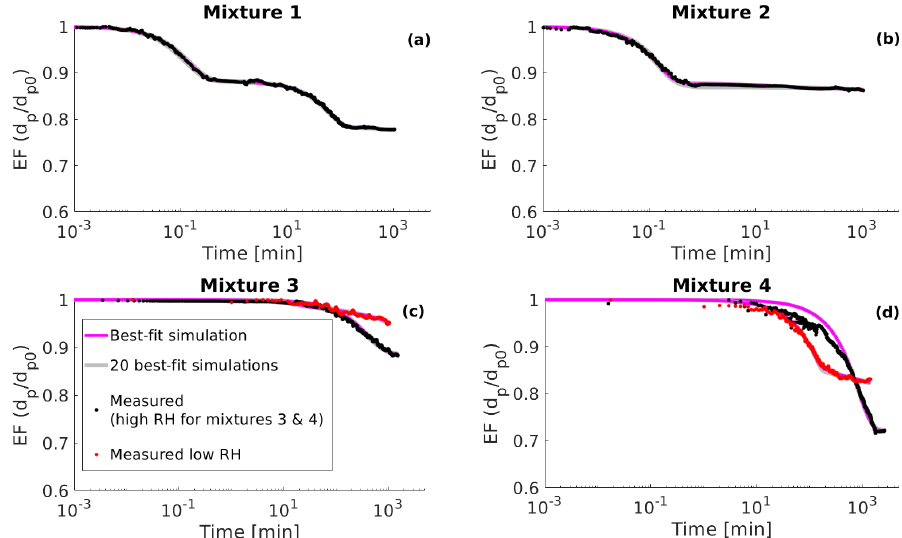
Figure 6. (a) Measured evaporation factors (EF, particle diameter d p divided by the initial diameter d p0 ) of mixture 1 from the determined point of water equilibrium (see Sect. 5) (black circles), 20 best-fit simulations (grey lines) and the best-fit simulation (magenta line). (b) Same as panel (a) but for mixture 2. (c) Measured evaporation factors of mixture 3 from the determined point of water equilibrium under high RH conditions (RH = 70%, black circles) and low RH conditions (RH = 25%, red circles). Grey lines show 20 best-fit simulations and magenta line the best-fit simulation; (d) same as panel (c) but for mixture 4 for which the high RH is 86.5% and low RH is 25.1%. The best-fit simulation is determined as the evaporation simulation that produces the smallest mean squared error relative to the measurement